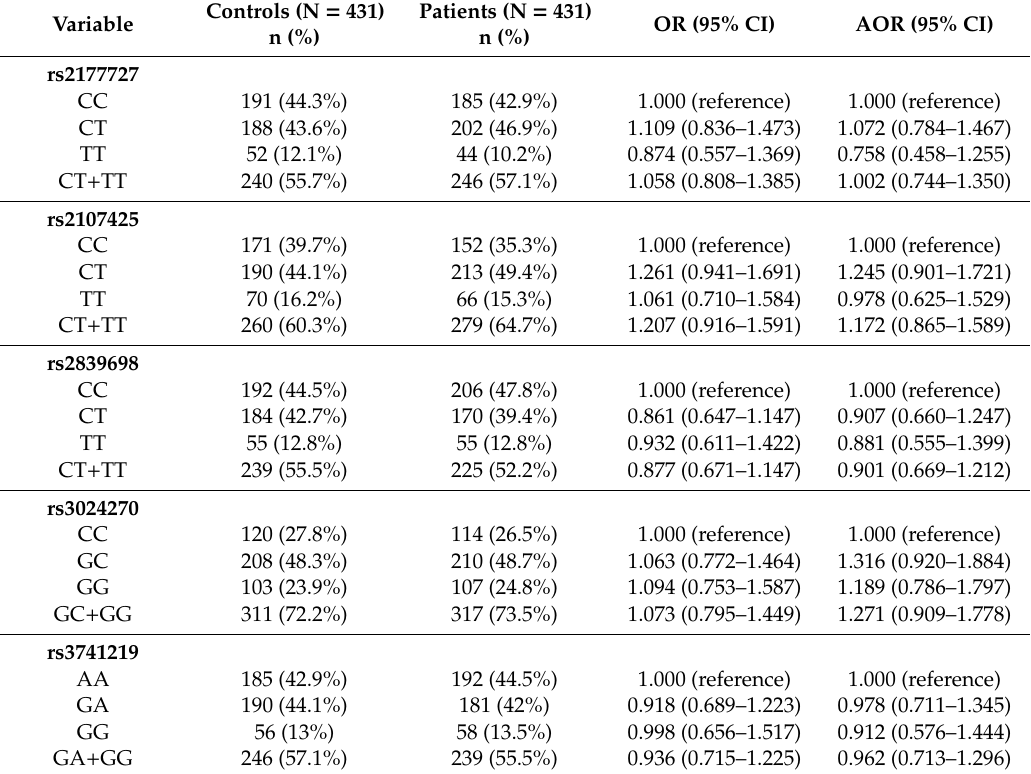
Table 2. Genotype distributions of H19 gene polymorphisms in 431 controls and 431 patients with